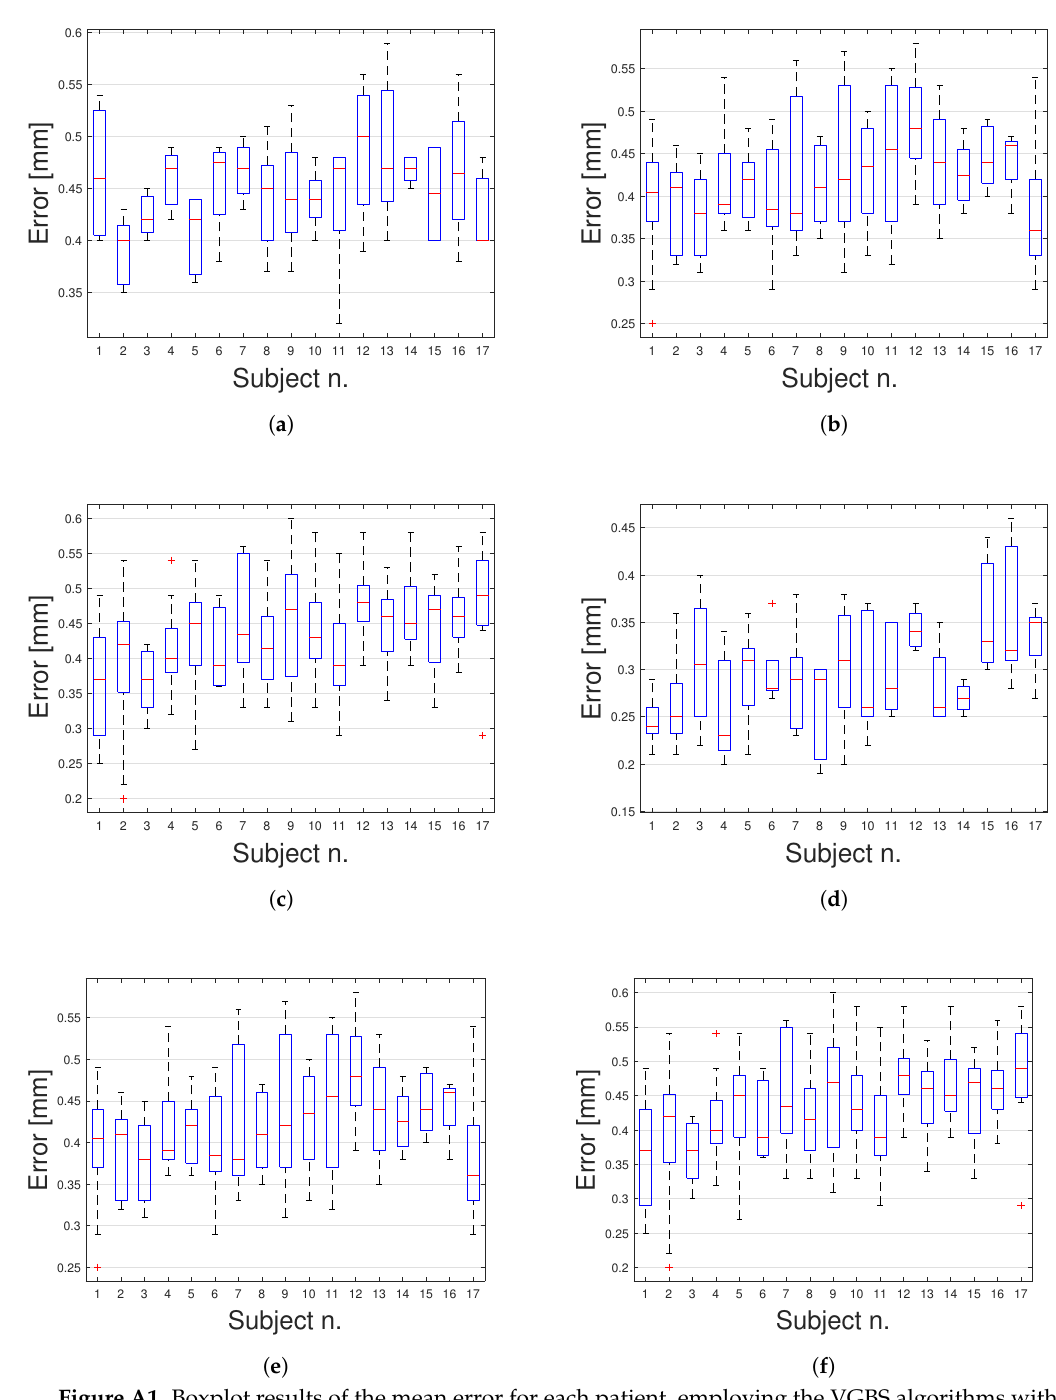
Figure A1. Boxplot results of the mean error for each patient, employing the VGBS algorithms with different numbers of bands. ( a ) Five selected bands using SURF. ( b ) Ten selected bands using SURF. ( c ) Fifteen selected bands using SURF. ( d ) Five selected bands using DELF. ( e ) Ten selected bands using DELF. ( f ) Fifteen selected bands using